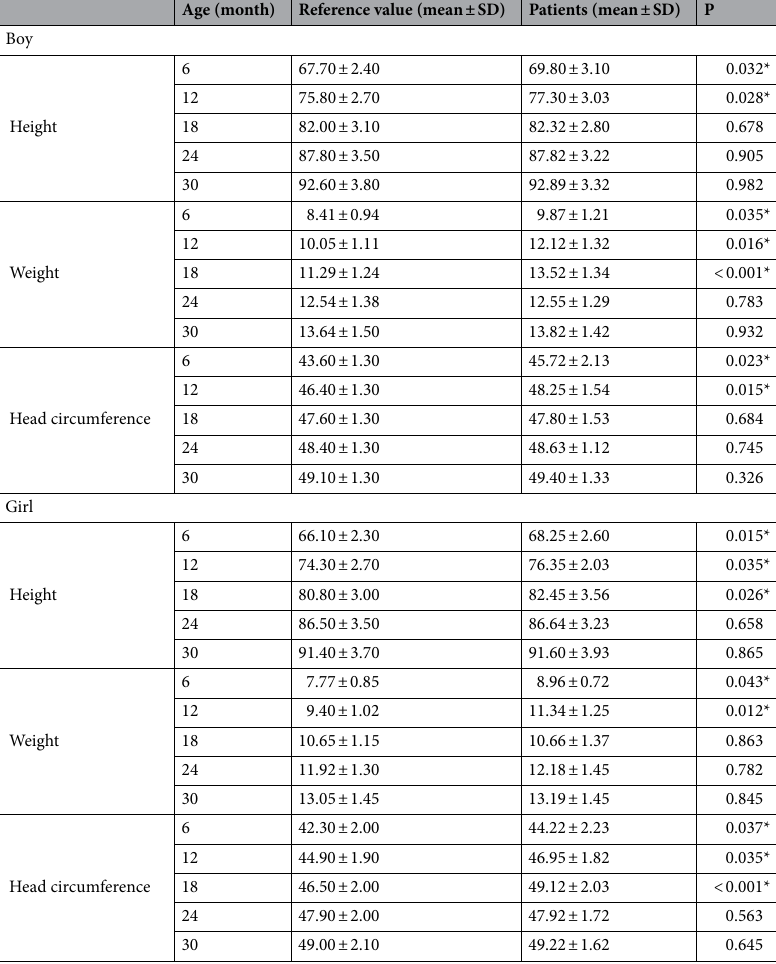
Table 3. Height, weight and head circumference comparison in patients (n = 112). *P ＜ 0.05